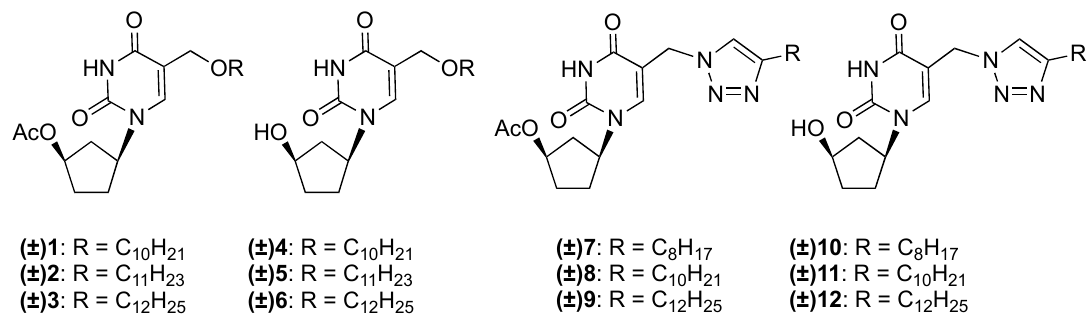
Figure 3. Target compounds.